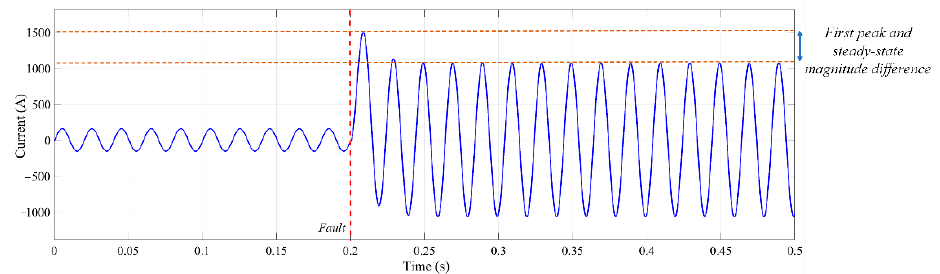
Figure 2. Fault current of a distribution system.